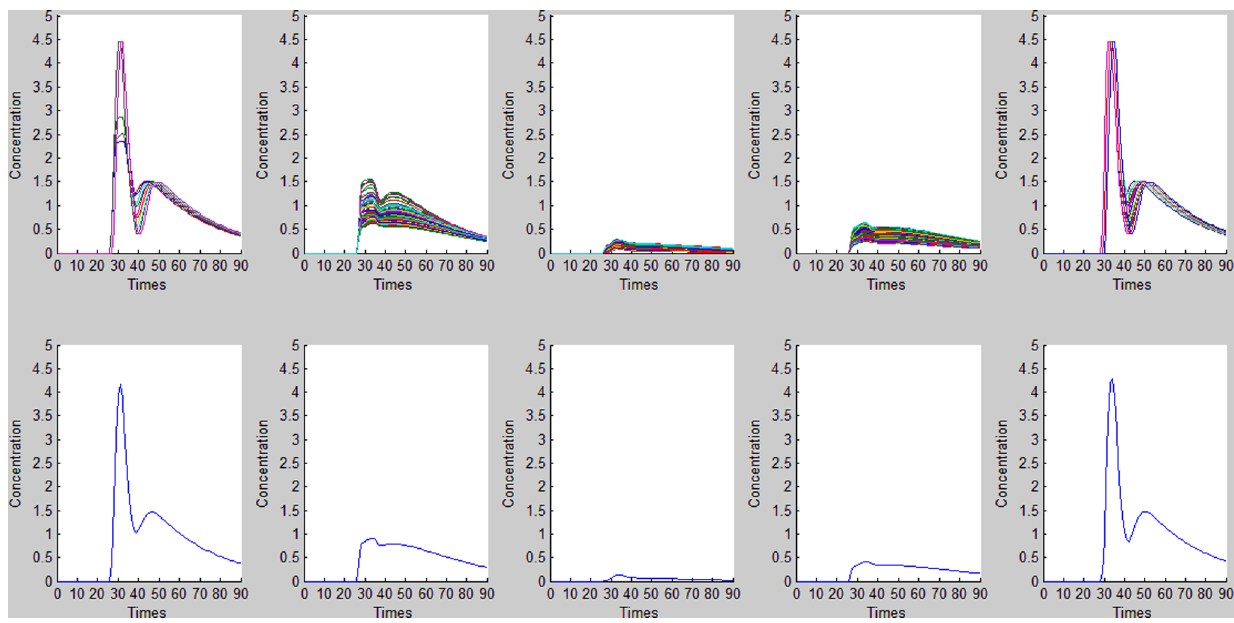
Figure 2. K-means cluster analysis results for AIF detection. Top: time–concentration curves for different clusters. Bottom: mean curve for M values of 0.0212, 5.8216e-004, 1.7180e-004, 2.3354e-004, 0.0205, respectively. The mean curve for M =0.0212 was thus selected to represent the estimated AIF.